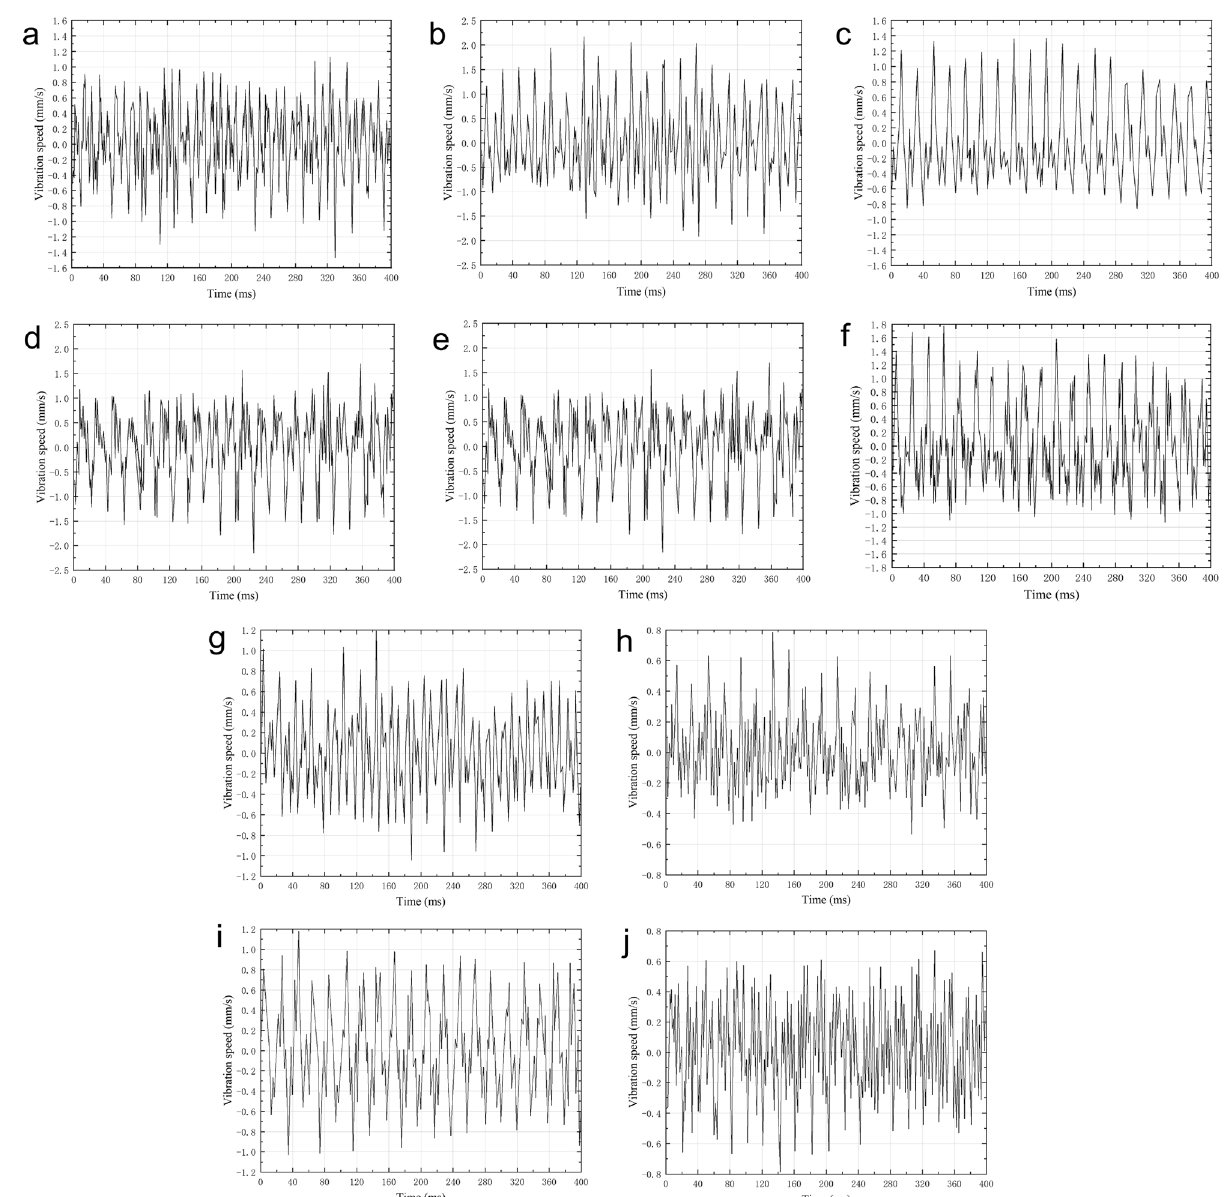
Figure 10. Time-domain waveforms of vibration speed at rated flow. ( a ) Point 1. ( b ) Point 2. ( c ) Point 3. ( d ) Point 4. ( e ) Point 5. ( f ) Point 6. ( g ) Point 7. ( h ) Point 8. ( i ) Point 9. ( j ) Point